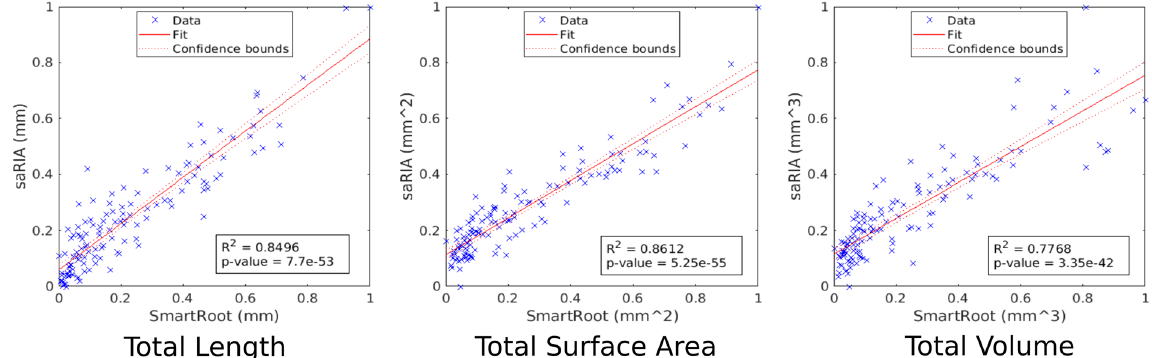
Figure 6. Correlation between root traits calculated using semi-automated saRIA (y-axis) and manual SmartRoot (x-axis) image segmentation. Each point represents a trait value estimated from one of 126 soil- root images. The red color solid line and dotted lines represent a fitted curve and 95% confidence bounds, respectively. The R 2 value indicates good conformity between saRIA and SmartRoot results of image segmentation and trait calculation.